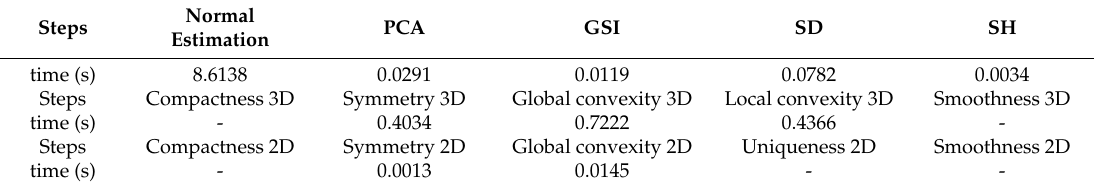
Table 3. Computational time comparison of major steps in the feature extraction phase.